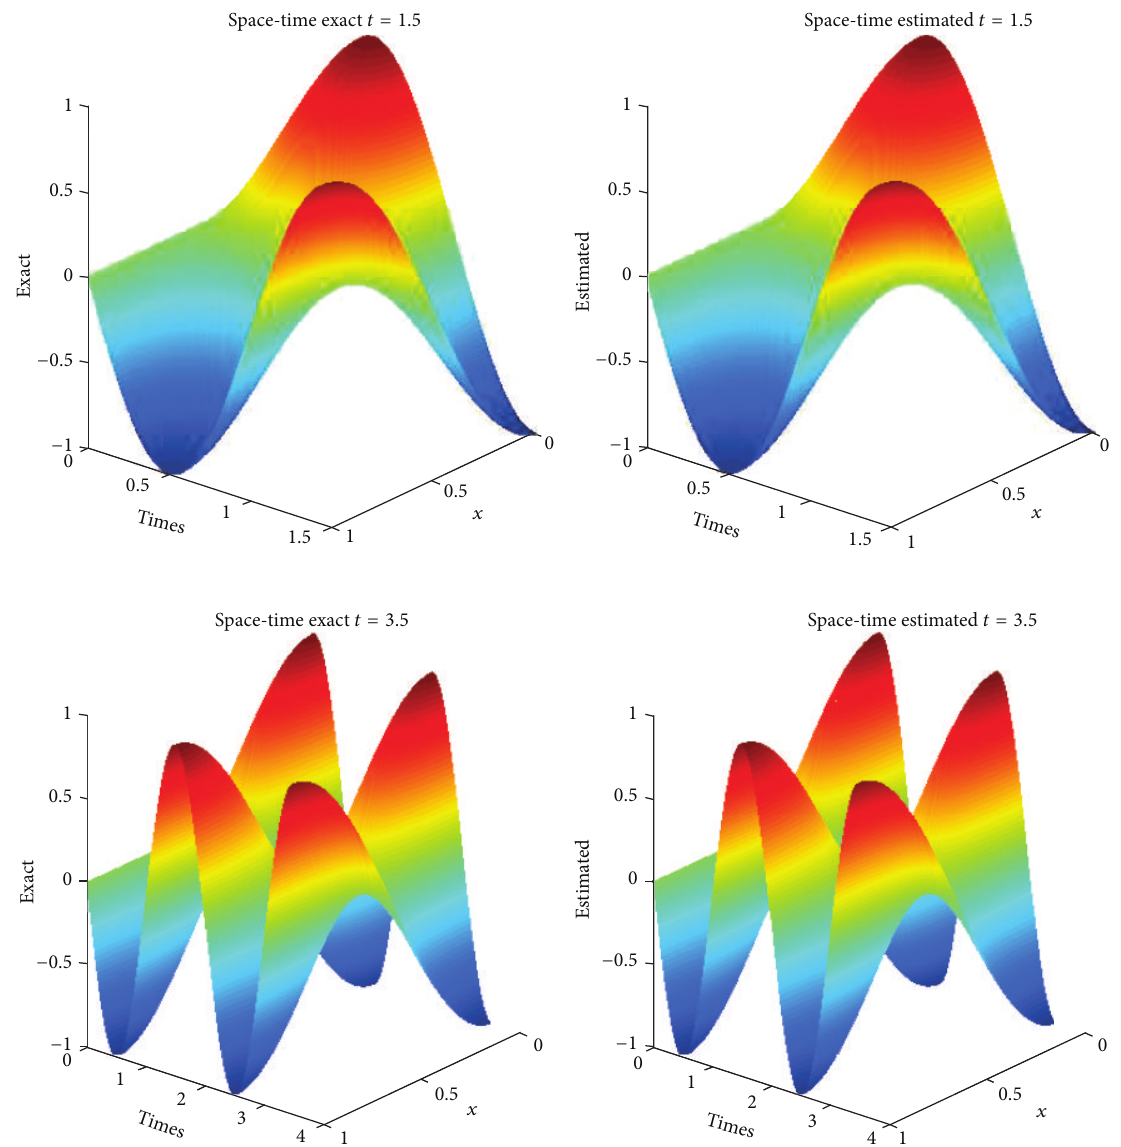
Figure 4: Space-time graph of numerical and analytical solutions at time 𝑡 = 1.5, 3.5 with 𝑑𝑥 = 0.01 , 𝑑𝑡 = 0.001 and using TPS ( 𝑚 = 2 ) as the radial basis function for Example 4